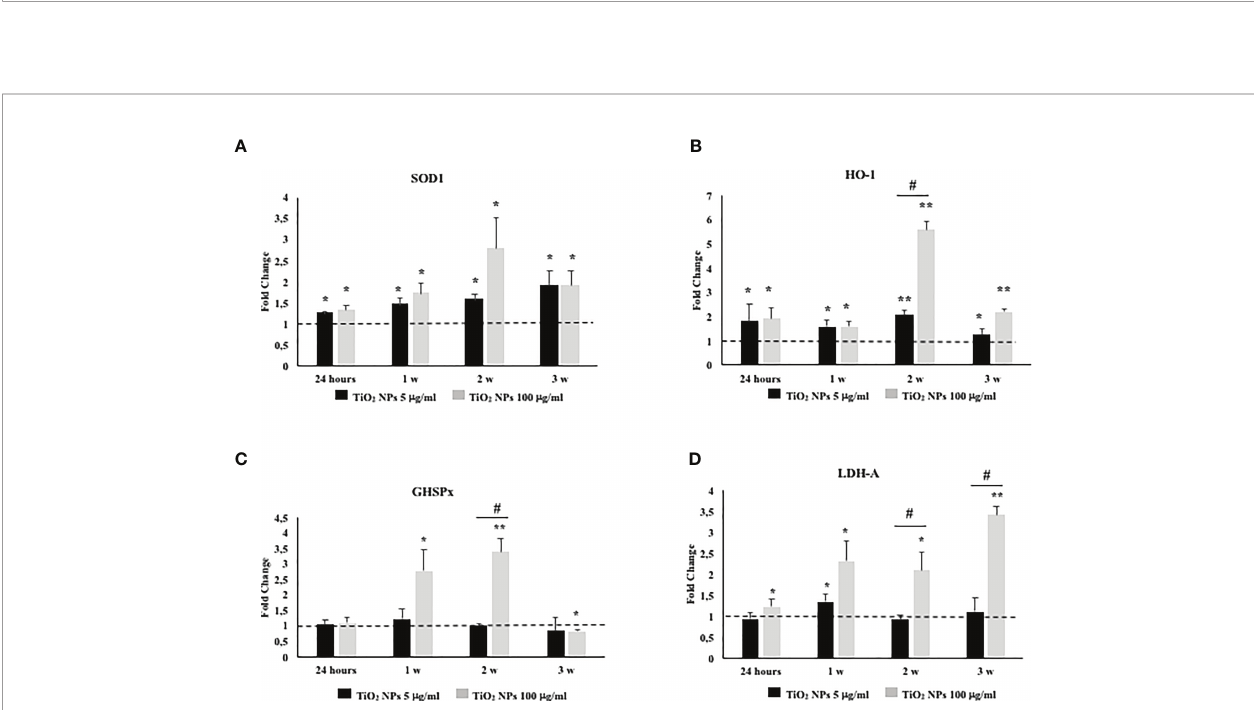
FIGURE 8 | Real-time PCR analysis of SCs antioxidant and metabolic enzymes. Gene expression of SOD1 (A) , HO-1 (B) , GHSPx (C) , and LDH A (D) in SCs at 24 h and 1, 2, and 3 weeks of incubation with TiO 2 NPs 5 (black bar) and 100 µg/ml (grey bar). Data represent the mean ± SEM (* p < 0.05, ** p < 0.001 vs. unexposed SCs (black dotted line) and # p < 0.05 vs. 5 m g/ml of TiO 2 NPs of three independent experiments, each performed in